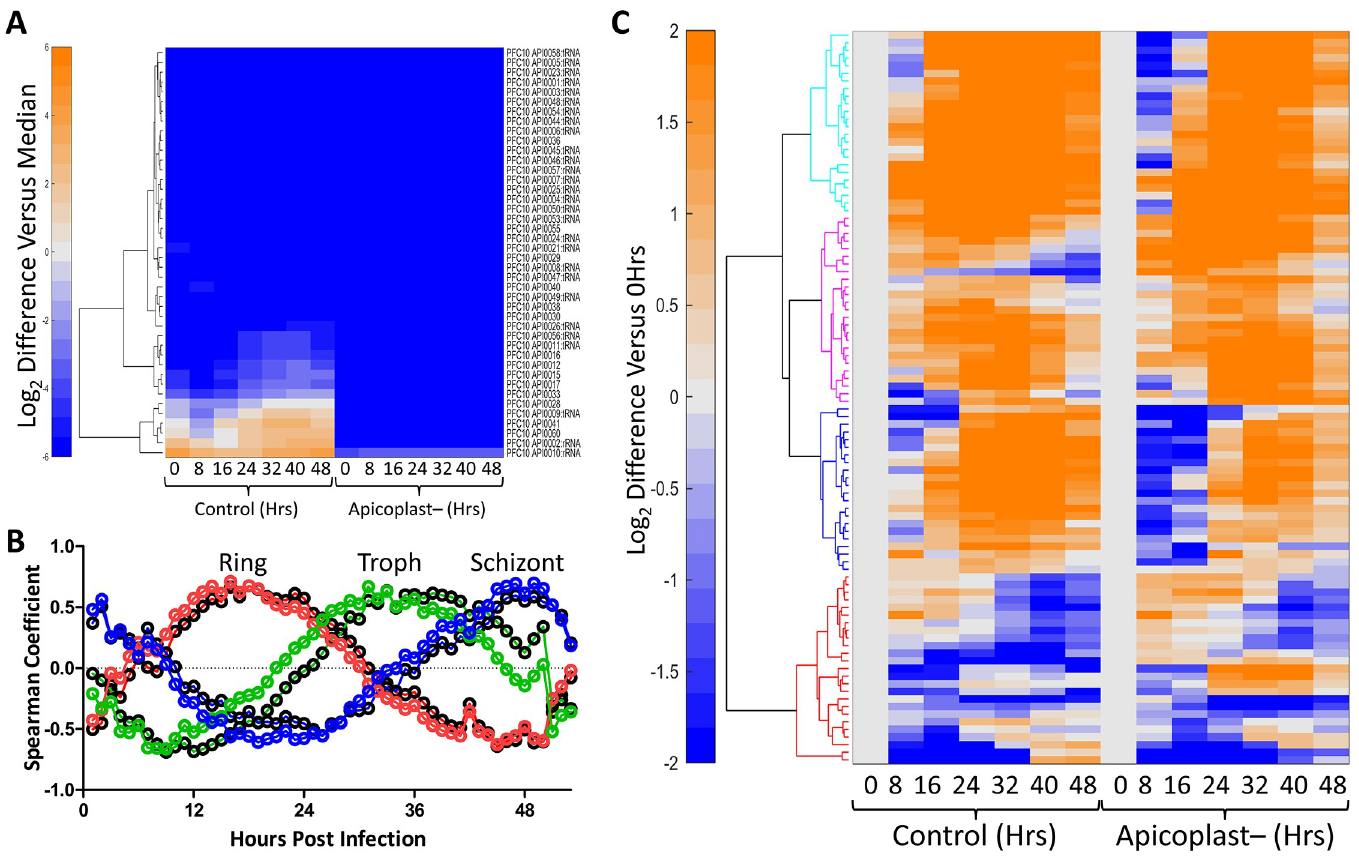
Fig 7. Transcriptomic analysis of apicoplast-disrupted parasites. A) Hierarchical clustering of apicoplast genome expression from control and apicoplast-disrupted parasites during the IDC. The apicoplast gene expression data were normalized by the median expression of 5851 genes from corresponding parasites at each time point before performing the clustering. We used Euclidean distance measure, along with Ward’s method, to create the hierarchical clusters in MATLAB. The expression profile of the apicoplast genes from the apicoplast-disrupted parasites is minimal confirming that the organelle is missing. The values are shown on a log 2 scale. B) Spearman coefficient values were calculated by comparing the global transcriptional data generated from control (black circles) and apicoplast disrupted (colored circles) parasites at the indicated time points against corresponding data from each time point generated in the high-resolution 3D7 IDC transcriptome from Llina´s and coworkers [39]. The y-axis shows Spearman coefficient; the x-axis shows hours post invasion in the IDC data set. The apex of the peak in each graph corresponds to the approximate point in the IDC to which apicoplast-disrupted parasites best correlate at the indicated incubation time. Plots are shown with a Loess fit of the data: 16hrs (red), 32hrs (green), and 48hrs (blue). C) Hierarchical clustering of transcriptomic data, of 96 high-confidence apicoplast genes, from control and apicoplast-disrupted parasites at the indicated time points. The expression profile of each gene was normalized by its expression at time point 0 to visualize variation in their temporal profile, in response to apicoplast disruption. Four distinct clusters are shown (cyan, magenta, blue, and red) and are further described in S3 Fig . The clustering method used here is identical to that described for